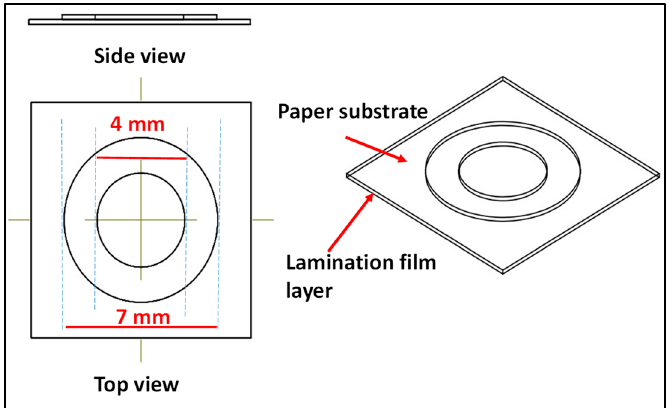
Figure 4. Schematic representation of the dimensions and design of the paper pad.